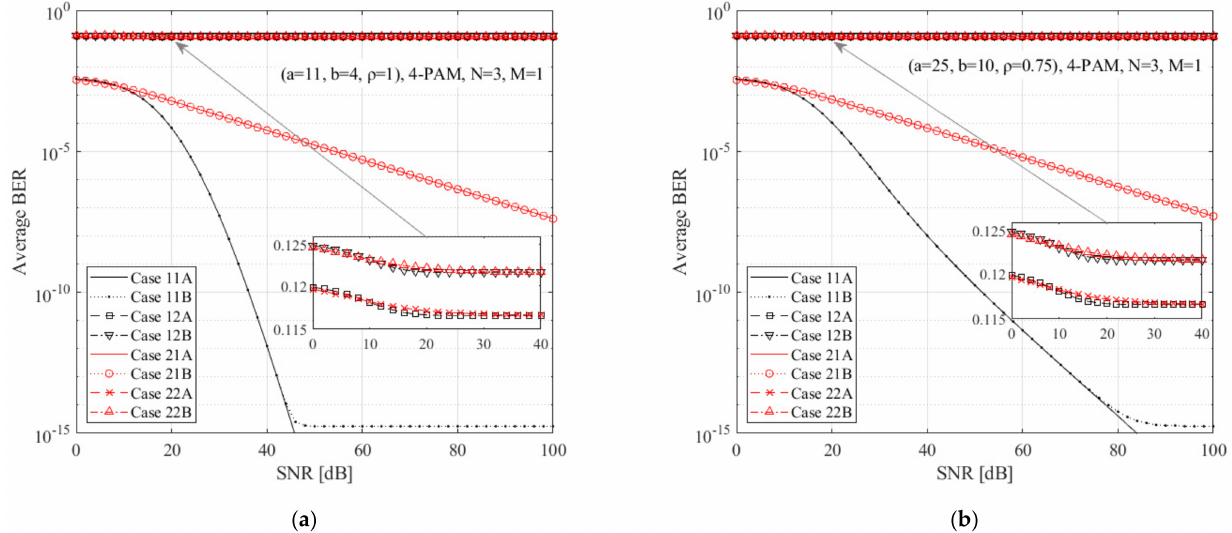
Figure 4. ABER versus expected SNR for 4-PAM scheme, N = 3, M = 1, with various bitrates and spatial and time jitter conditions of ( a ) ( a = 11, b = 4, ρ = 1) and ( b ) ( a = 25, b = 10, ρ = 0.75). The studied curve cases are codified as in Figure